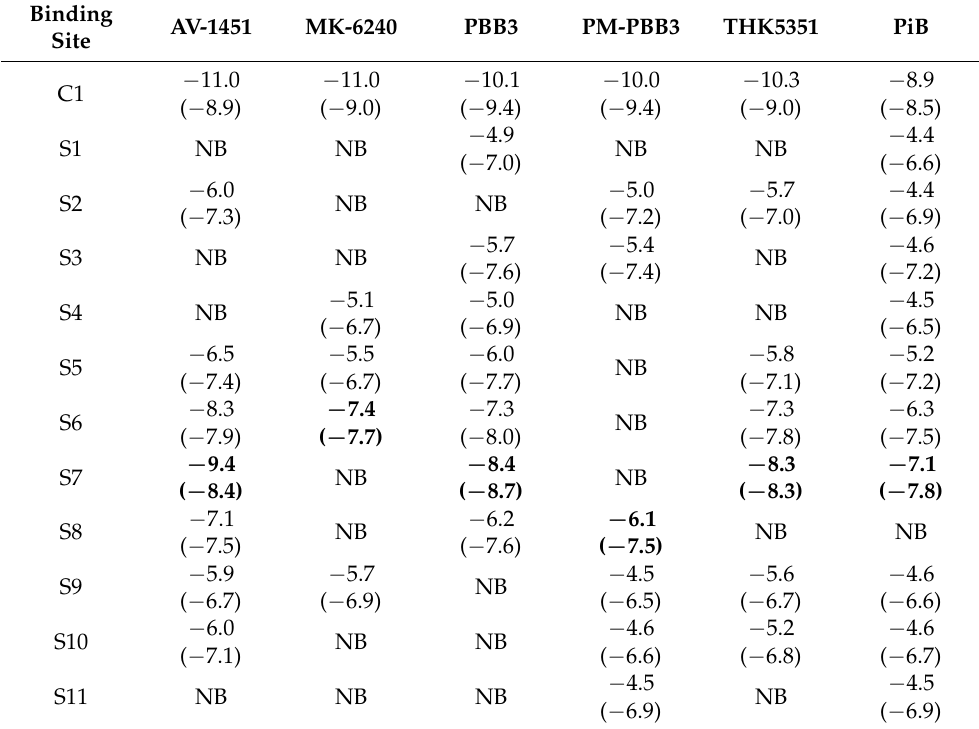
Table 1. Calculated docking scores (kcal · mol − 1 ) from molecular docking of various PET probes in the different binding sites of Tau PiD protofibril. Values in brackets are the binding energies from the rescoring function X-Score for the same binding pose. Site C1 corresponds to a cavity site while the remainder (S1 to S11) correspond to surface binding sites. Corresponding binding sites are shown in Figure 1B. Binding